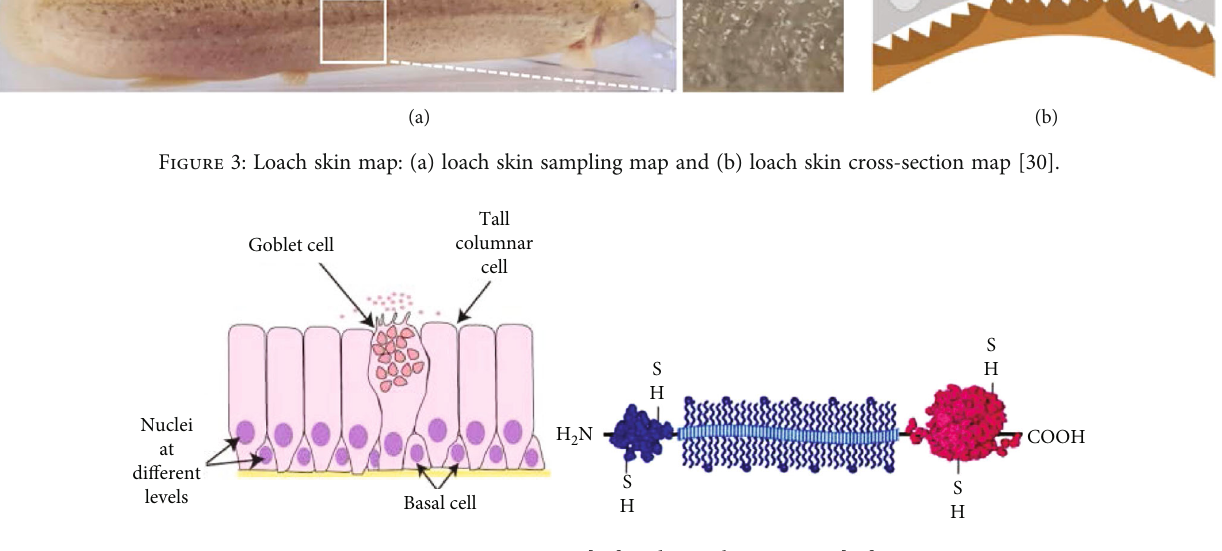
Figure 4: Mucus secretion [97] and reticular structure